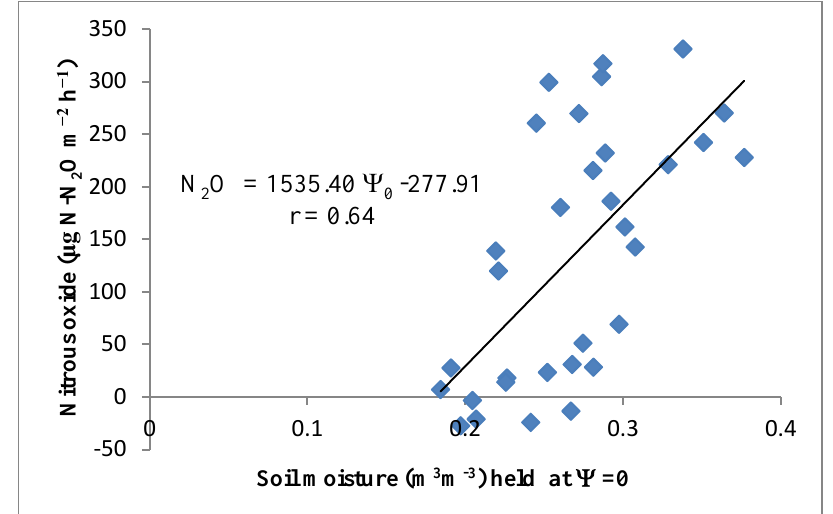
Figure 1. Correlation between soil moisture held at Ψ = 0 and N 2 O fluxes.